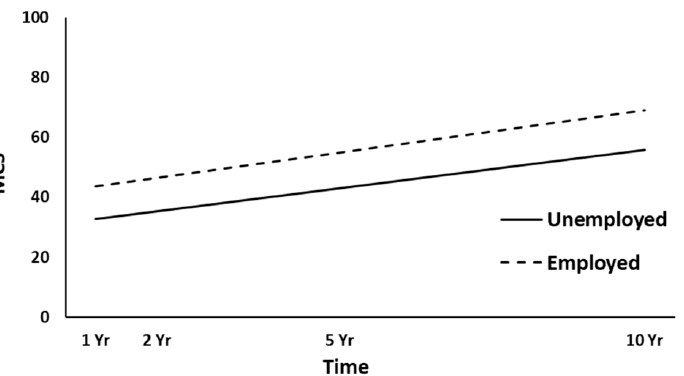
Figure 5. Main effect of gender on the mental health (MCS) trajectories. yr, year.